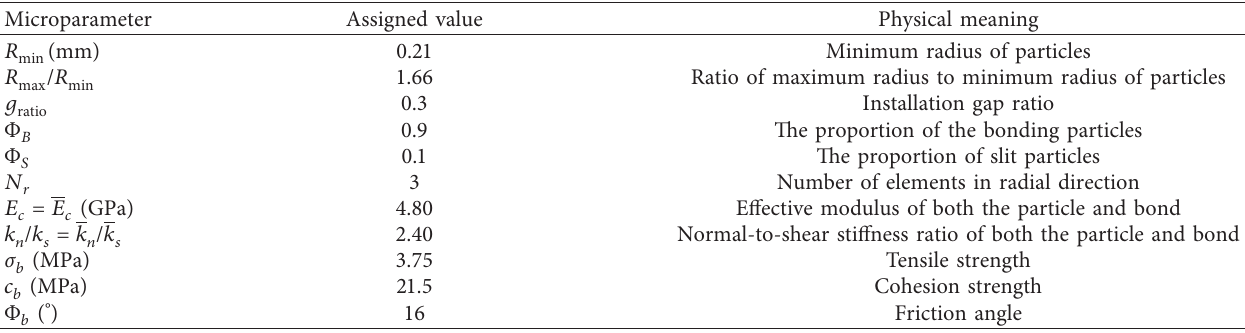
Table 3: Microparameters of the flat-joint model.